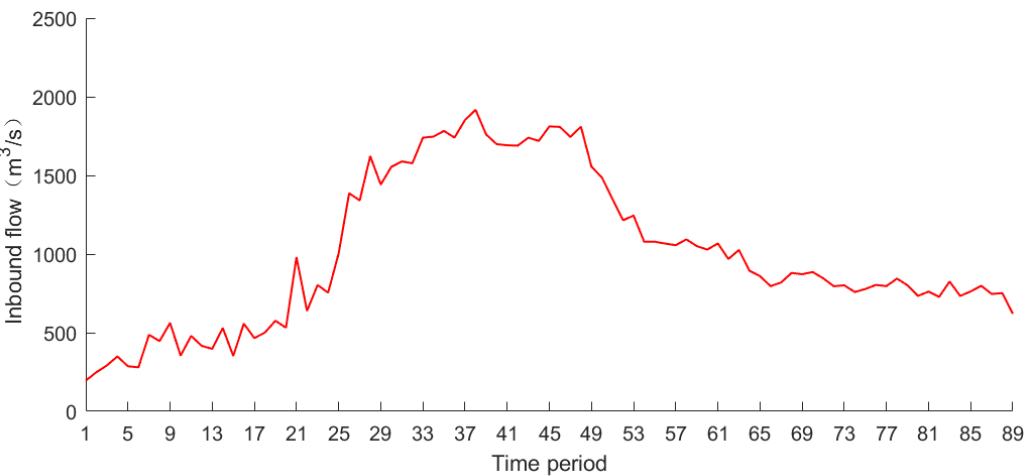
Figure 8. The inflow process line of the second flood.